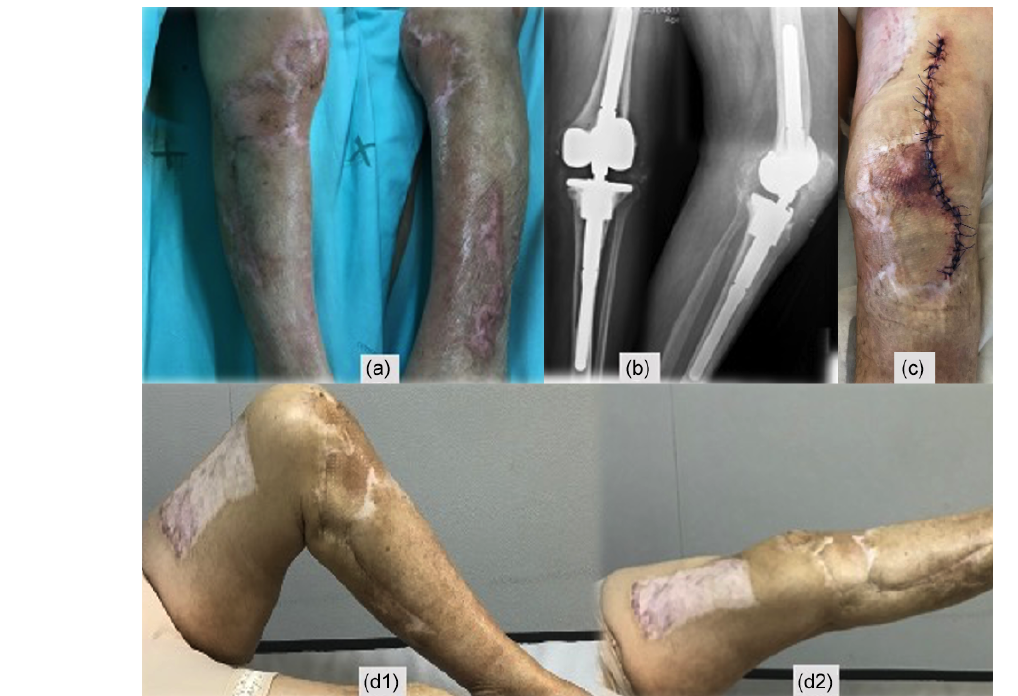
Figure 6. (a) Skin before the second-stage surgery, (b) post-operative X-ray, (c) skin fully healed, (d1–d2) left knee range of motion in the last evaluation, 0–115 ◦